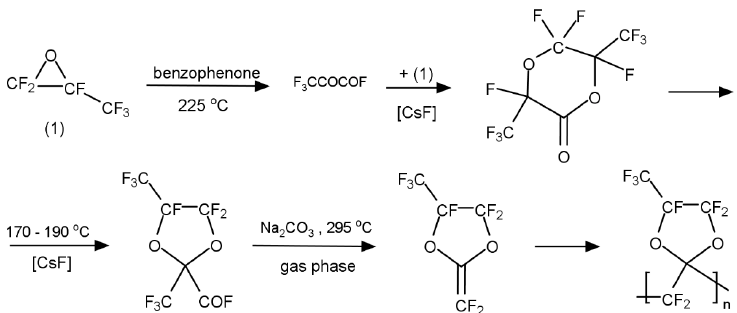
Figure 5. Synthesis of perfluoro-2-methylene 4-methyl 1,3-dioxolane and poly(PFMMD).